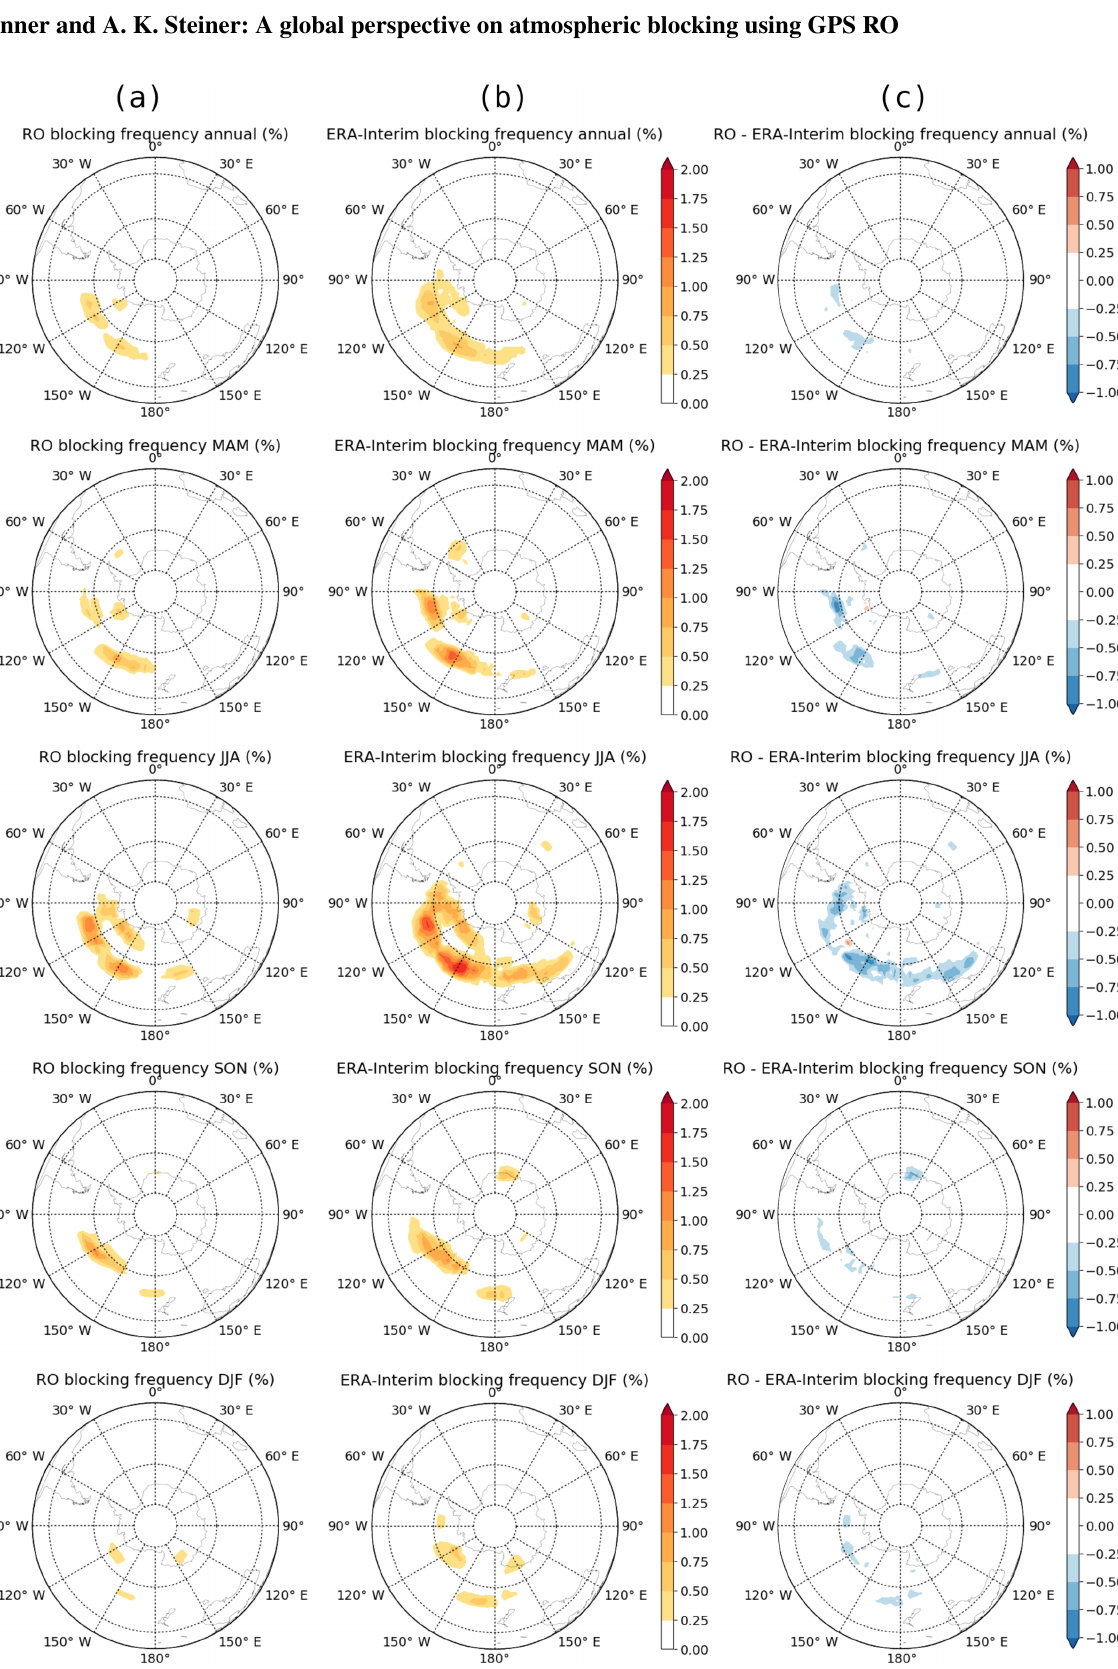
Figure 4. As Fig. 3 but for the Southern Hemisphere. Note the different colour bar ranges compared to Fig.